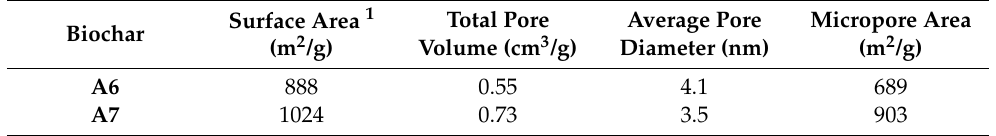
Table 2. Textural parameters of samples A6 and